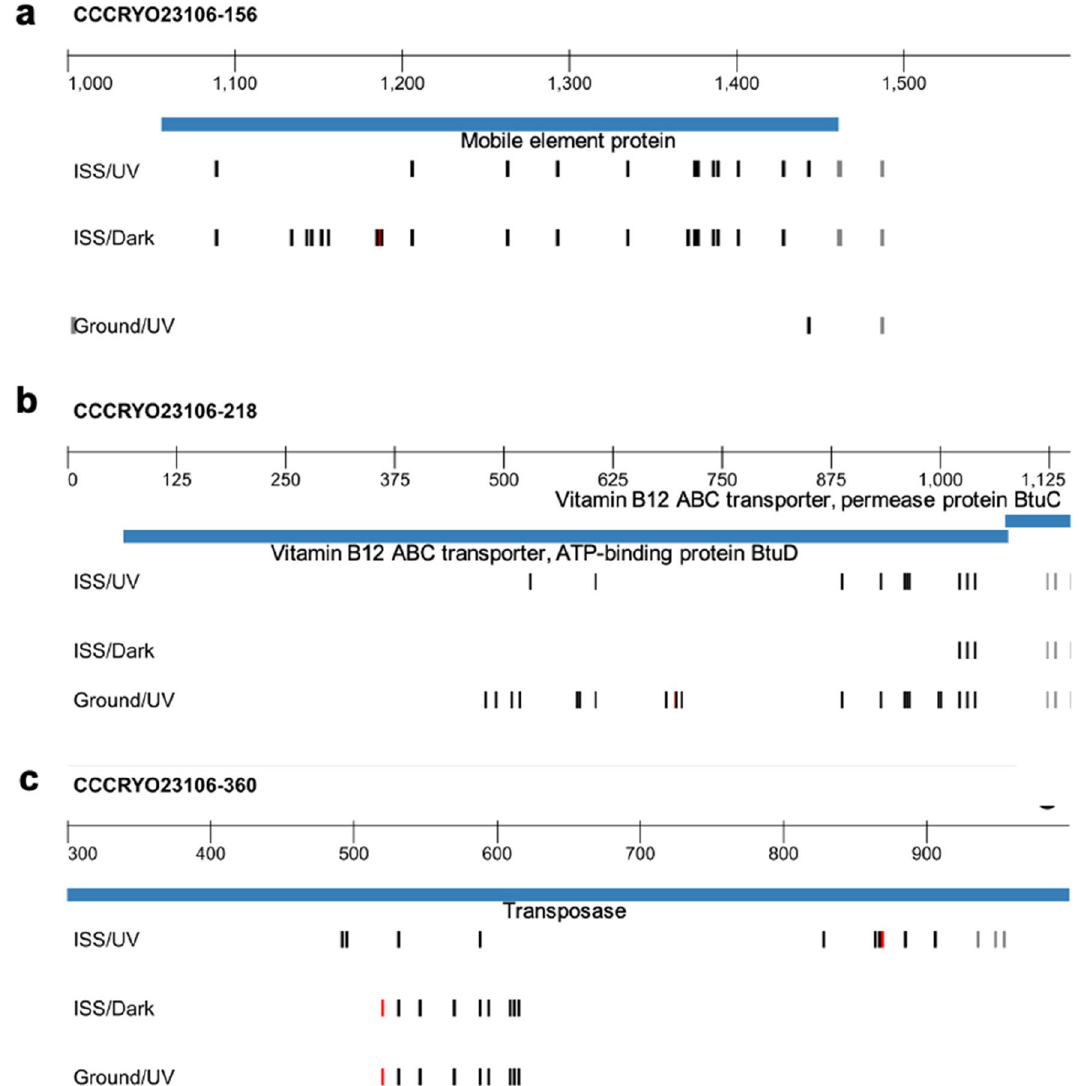
Figure 5. Selected synonymous (black) and non-synonymous (red) Nostoc sp. CCCryo 231-06 in BG11 medium variant profiles, where non-synonymous variants with respect to the consensus genome result in a change in amino acid. ( a ) Mobile element protein variant profile showing a high similarity between ISS/ Dark and ISS/UV conditions. ( b ) BtuD variant profile showing similar variants for all three conditions, but more similarity between Ground/UV and ISS/UV throughout the whole sequence. ( c ) Transposase variant profile Ground/UV and ISS/Dark display the same sequence, while ISS/UV displays a different variant. ISS international space station, UV ultraviolet light, ISS/UV ISS with UV exposure, ISS/Dark ISS without UV exposure, Ground/UV earth with UV